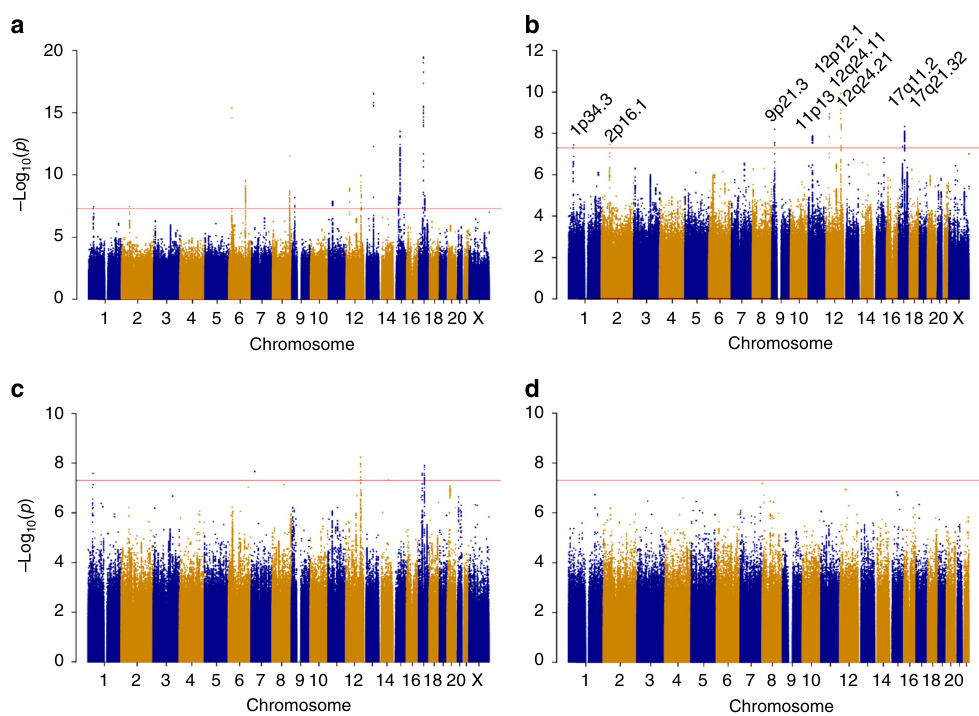
Fig. 1 Manhattan plot of the results of the endometrial cancer meta-analysis of 12,906 cases and 108,979 controls. Genetic variants are plotted according to chromosome and position ( x axis) and statistical signi fi cance ( y axis). The red line marks the 5 × 10 − 8 GWAS signi fi cance threshold. a Endometrial cancer (all histologies). b Endometrial cancer (all histologies) excluding variants within 500 kb of previously published endometrial cancer variants. c Endometrioid histology endometrial cancer excluding variants within 500 kb of previously published endometrial cancer variants. d